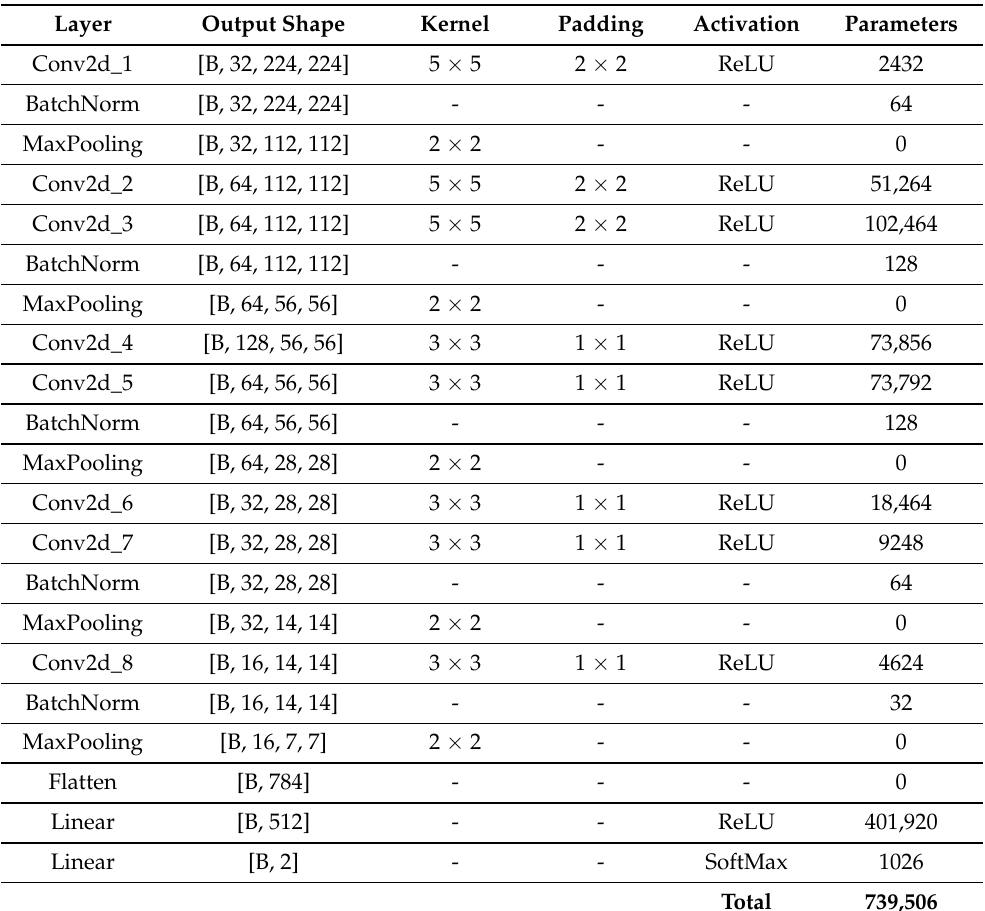
Figure 6. DRNet-Q proposed CNN architecture. Table 2. Detailed DRNet-Q